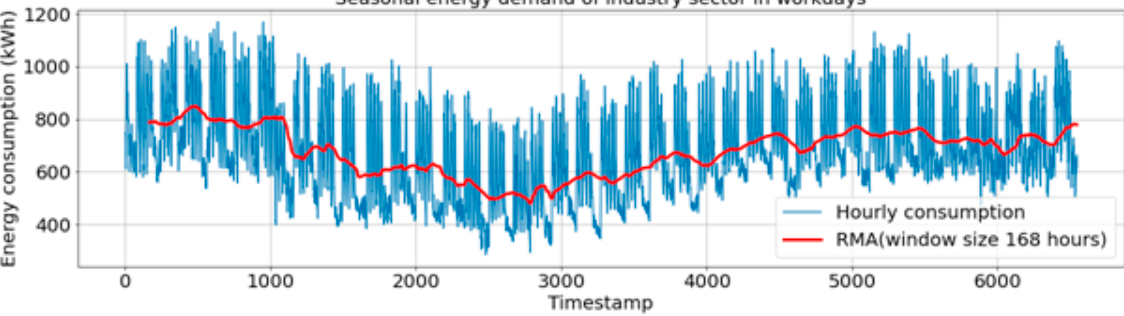
Figure 4. The industry energy consumption during workdays.